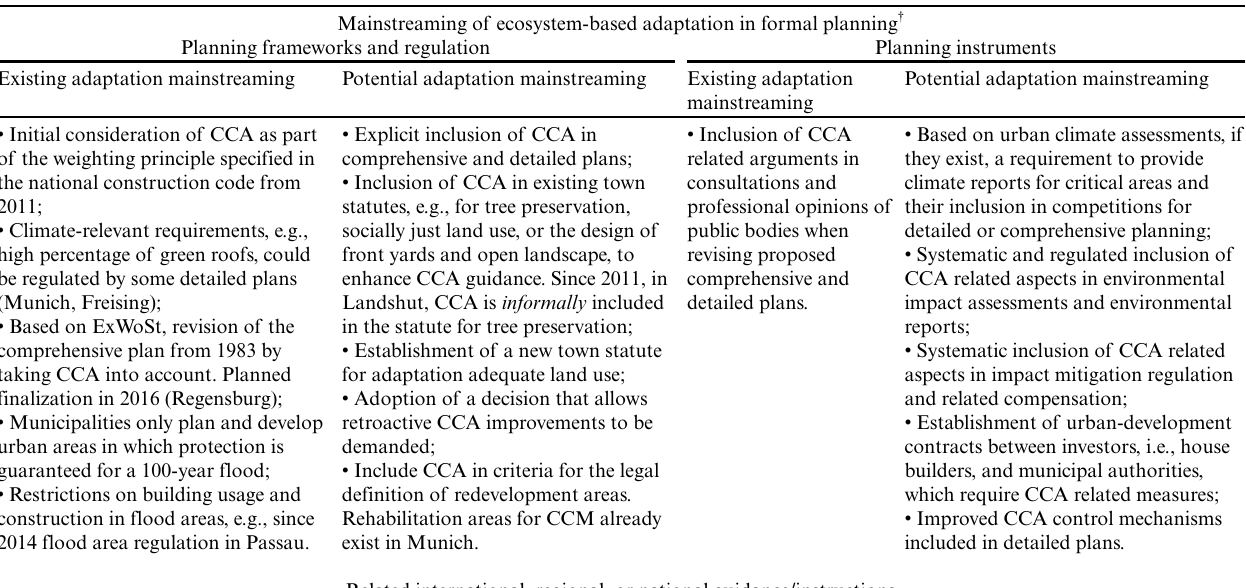
Table 3 . Existing and potential adaptation mainstreaming in formal planning frameworks, policies, and